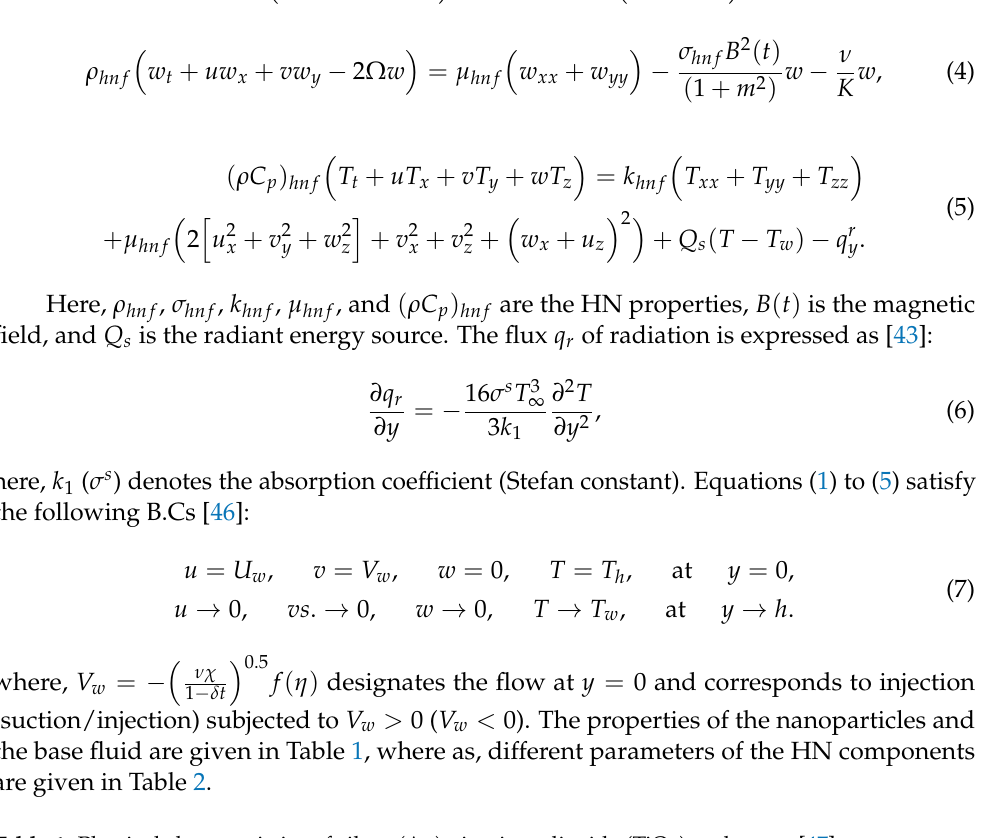
Table 1. Physical characteristics of silver (Ag), titanium dioxide (TiO 2 ) and water [47].